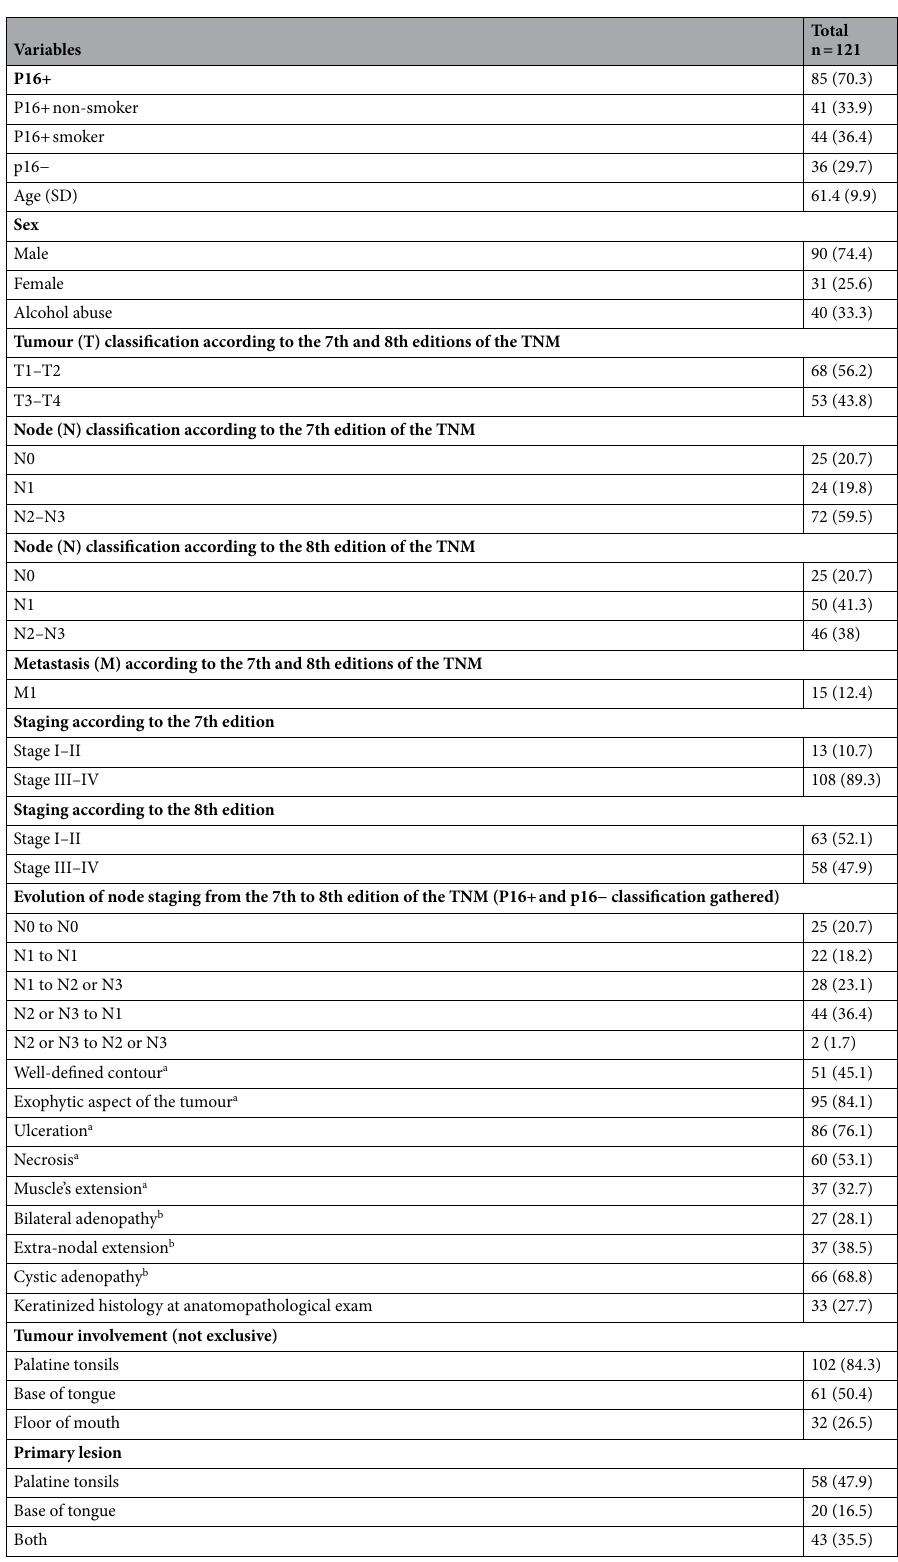
Table 1. Characteristics of patients (n = 121). Variables are displayed as number (%) or mean (standard deviation). a Data missing for 8 patients owing to no visible tumour (not visible clinically or on CT; pT1